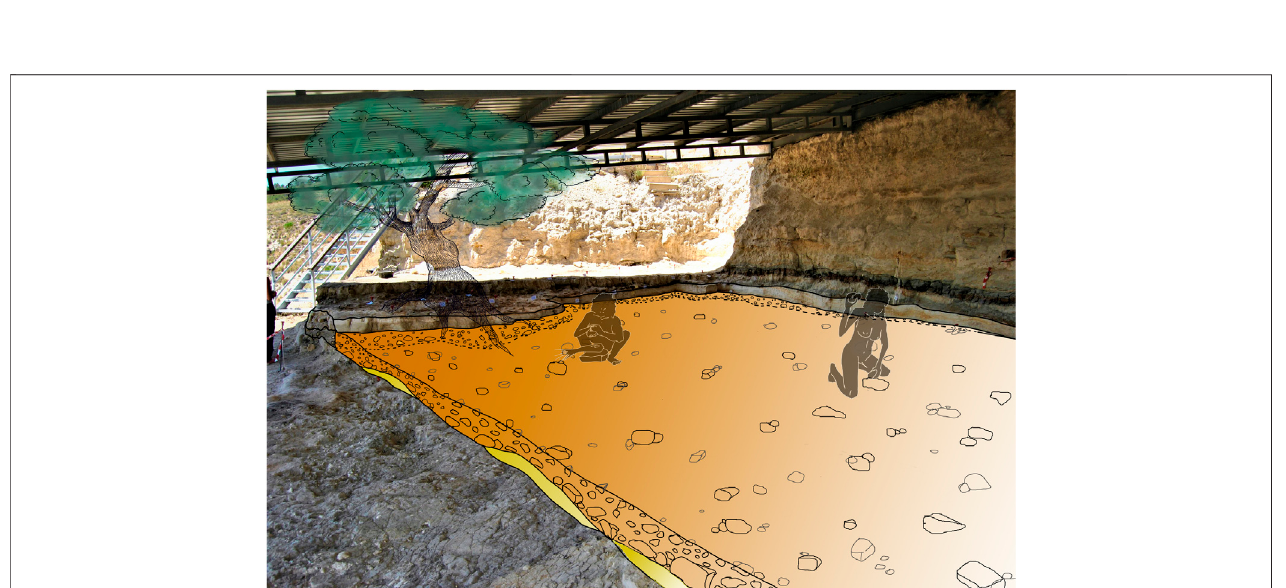
FIGURE 5 | Illustration of hominins exploiting lithic raw materials contained within layer D1 of the Barranco León site (drawn by S. Titton, Titton, 2021).